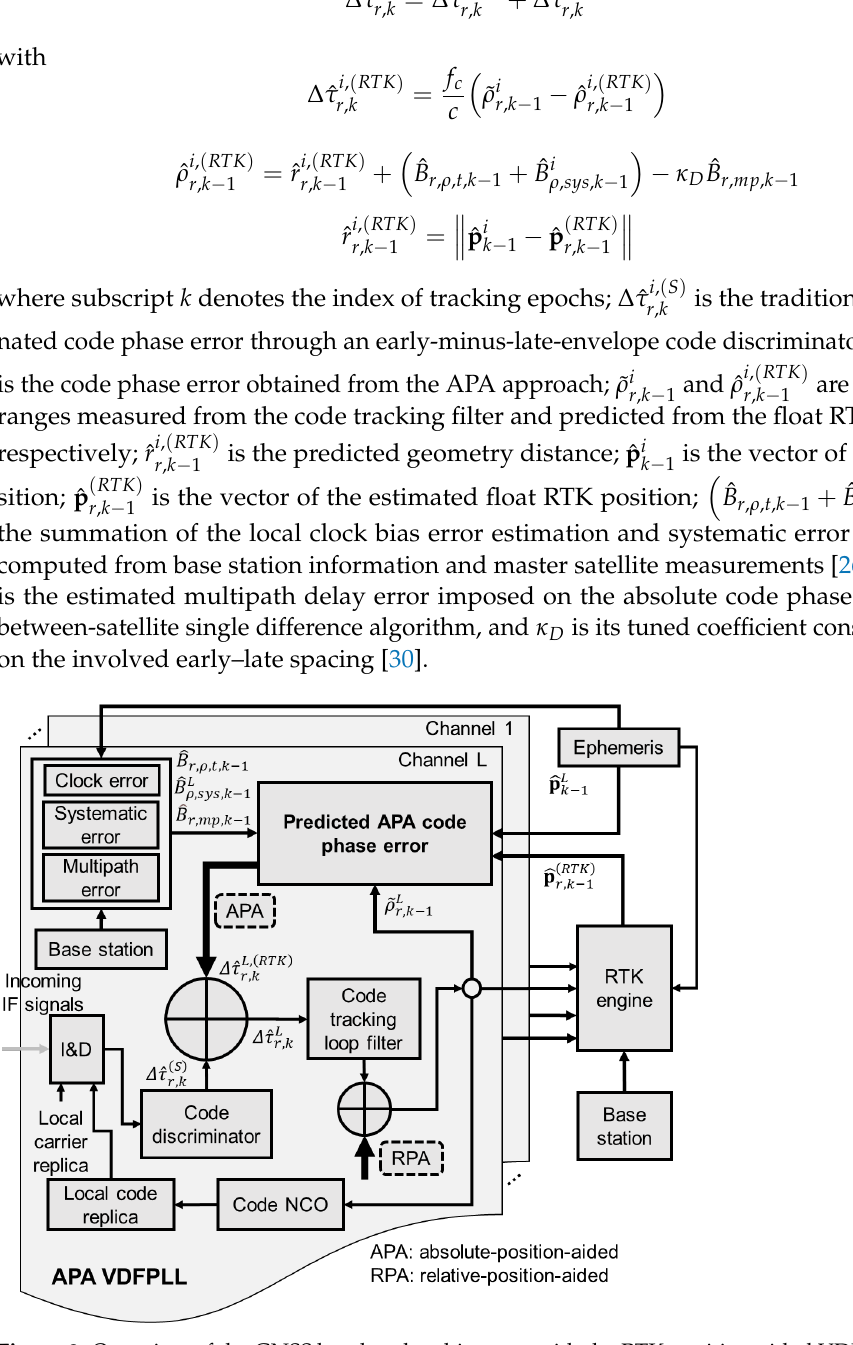
Figure 3. Overview of the GNSS baseband architecture with the RTK-position-aided VDFPLL